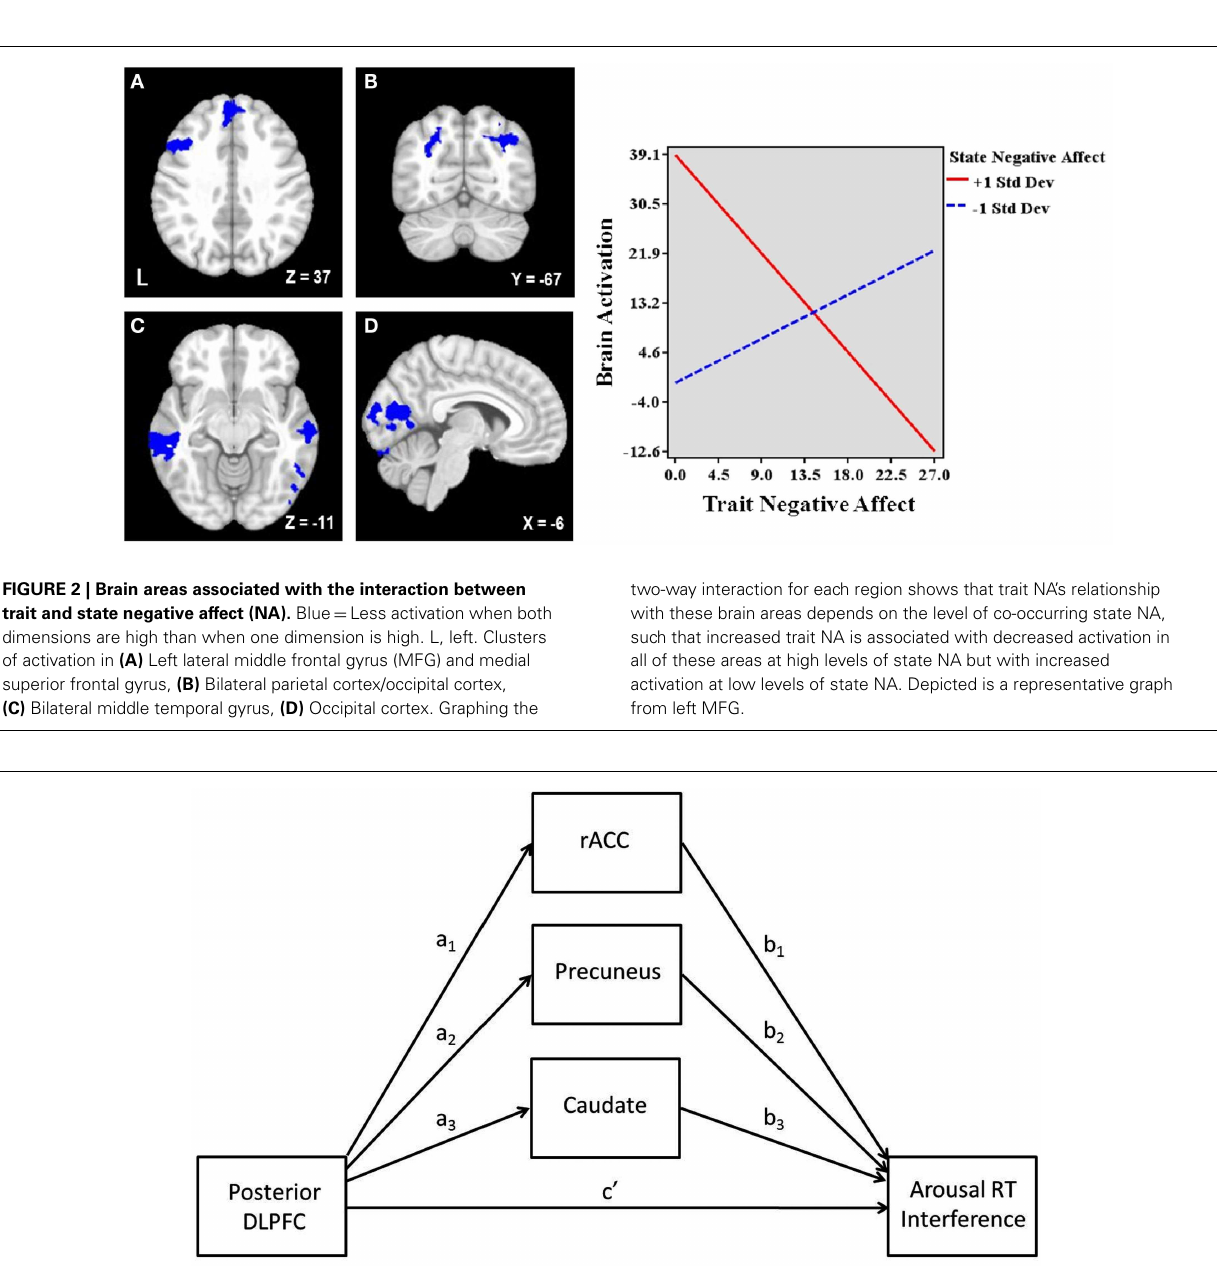
FIGURE 3 |The multiple mediation